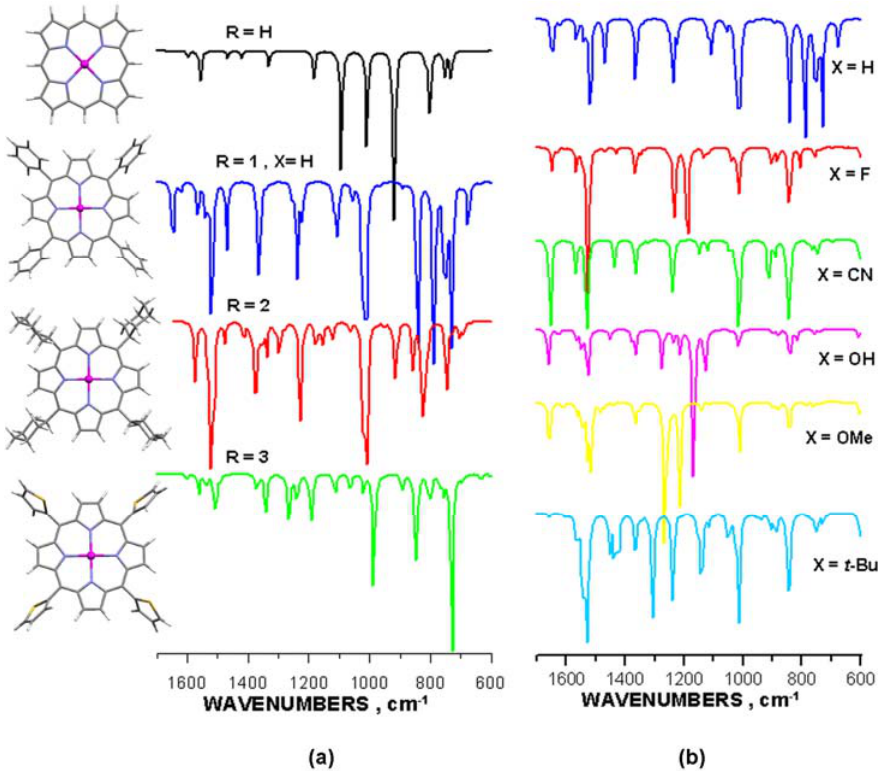
Figure 5. Infrared spectra calculated for selected Zn-porphyrins (raw results, not scaled). ( a ) Effect of the meso -substituent type. General molecular structure is shown; ( b ) Effect of the X-group in phenyl- meso